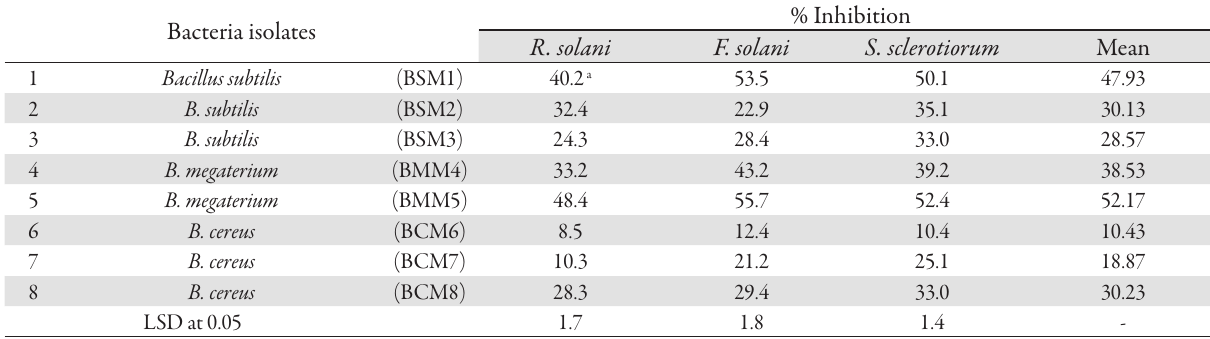
Tab. 3. In vitro antagonistic action between the bacterial isolates and the tested fungi Bacteria isolates